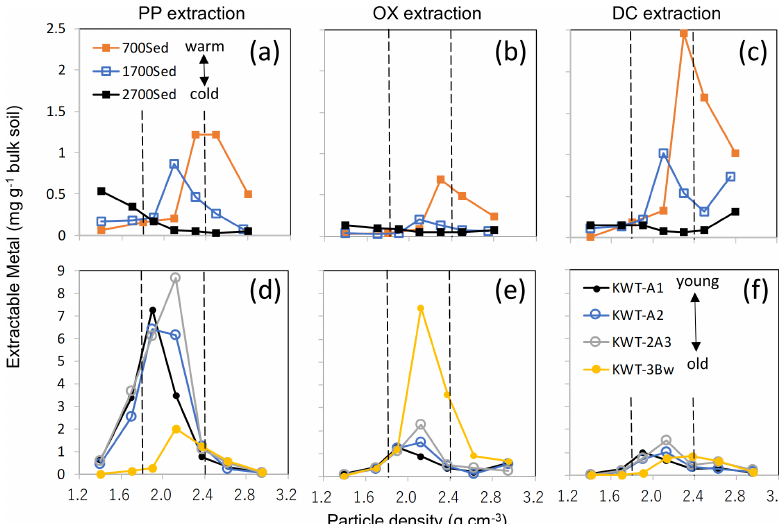
Figure A8. The distribution of the extractable metal phases (Al + 0.5Fe) along the particle density gradient for two soil series. The upper three plots show PP- (a) , OX- (b) , and DC-extractable metals (c) for three A horizon soils under tropical forest along an elevation gradient from a weathered soil under warm climate at 700m (sample ID: C5), moderately weathered soil at 1700m (C6), and much less weathered soil at 2700m (C7). The lower panels (d, e, f) showed surface and buried horizons of a non-allophanic Andisol profile (sample ID: N1–N4) that received multiple tephra deposits. Shaded zones show the meso-density